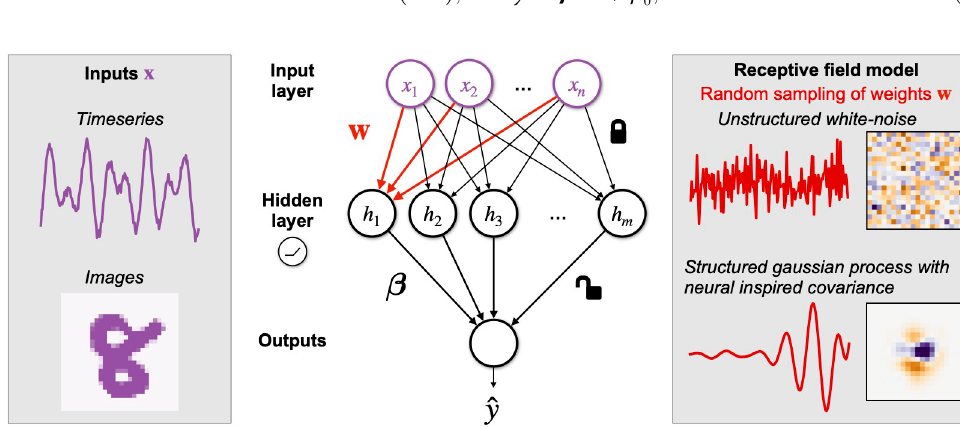
Fig 1. Random feature networks with structured weights. We study random feature networks as models for learning in sensory regions. In these networks, each neuron’s weight w is fixed as a random sample from some specified distribution. Only the readout weights β are trained. In particular, we specify distributions to be Gaussian Processes (GPs) whose covariances are inspired by biological neurons; thus, each realization of the GP resembles a biological receptive field. We build GP models of two sensory areas that specialize in processing timeseries and image inputs. We initialize w from these structured GPs and compare them against initialization from unstructured white-noise